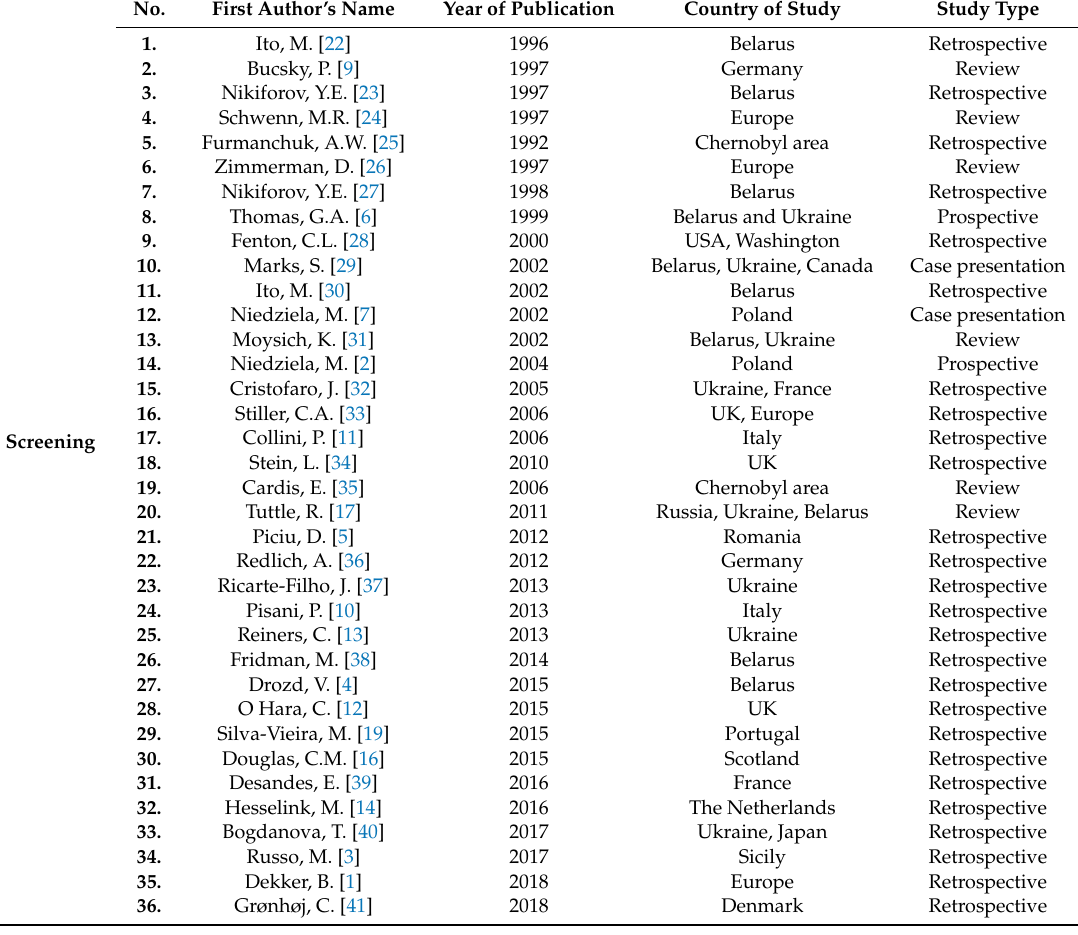
Table 1. The articles included in this review.